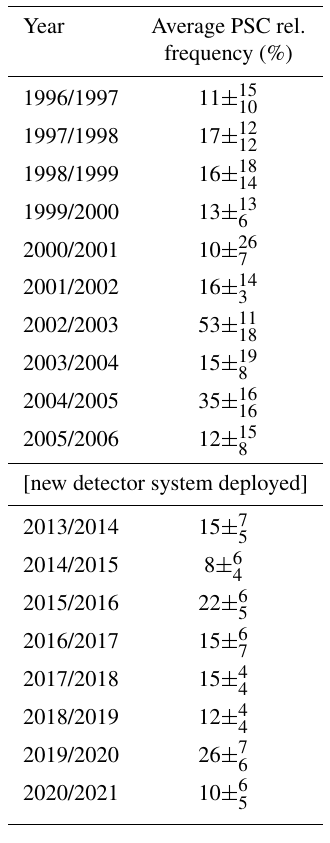
Table 2. The average PSC relative frequency in % above Kiruna for each winter season from November to